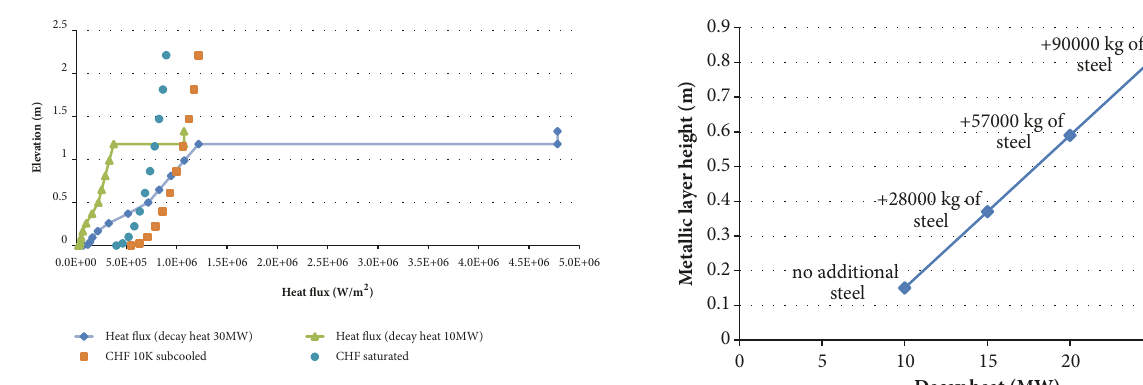
Figure 19: Calculated heat fluxes along the RPV wall. Decay heat 30 MW and 10 MW.